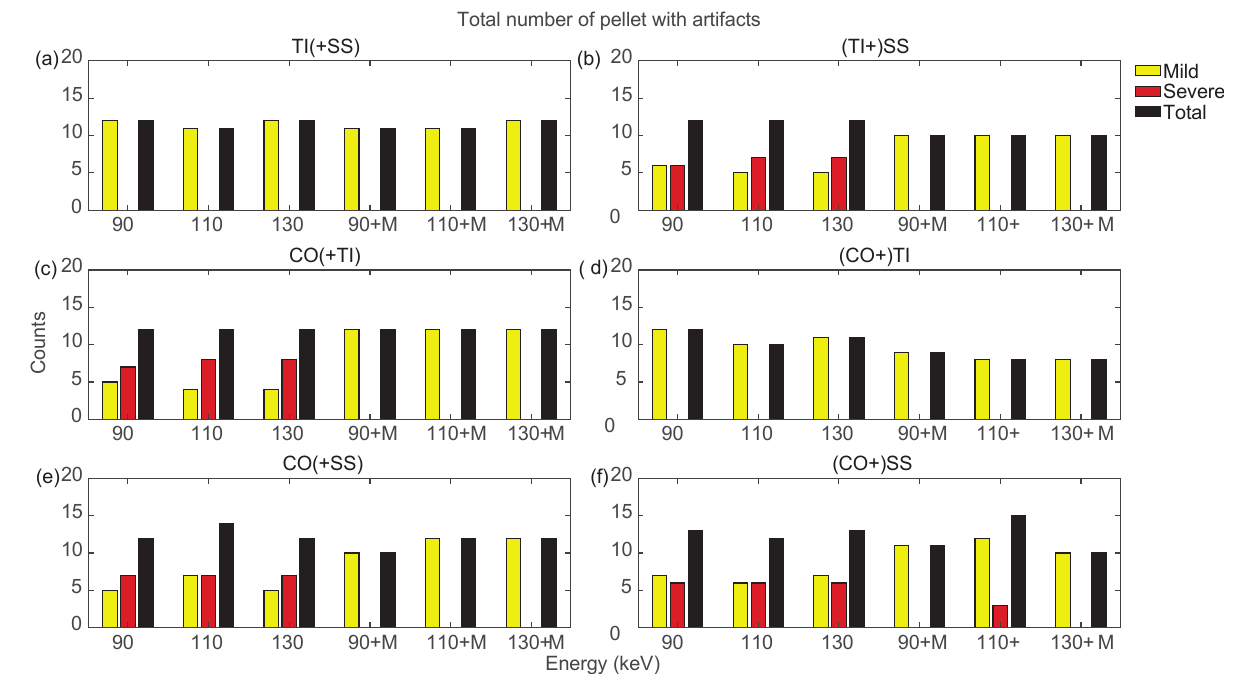
Figure 11. Counts for mild, severe, and total (sum of mild and severe) artifacts in prostheses from bilateral configurations, varying the reconstruction energies (VMI reconstructed without MARS, indicated as 90, 110, and 130, and VMI reconstructed with MARS, indicated as 90+M, 110+M, and 130+M). The counts of mild, severe, and total artifacts are indicated with yellow, red, and black bars, respectively. Results from TI(+SS) and (TI+)SS, CO(+TI), (CO+)TI, CO(+SS), and (CO+)SS configurations are displayed in panels ( a – f ), respectively. Table 3. Suggested combination of VMI and MARS to minimize metal artifacts for implant-specific CT imaging. The check mark (cid:88) indicates the conditions that generated the lowest number of total artifatcs.